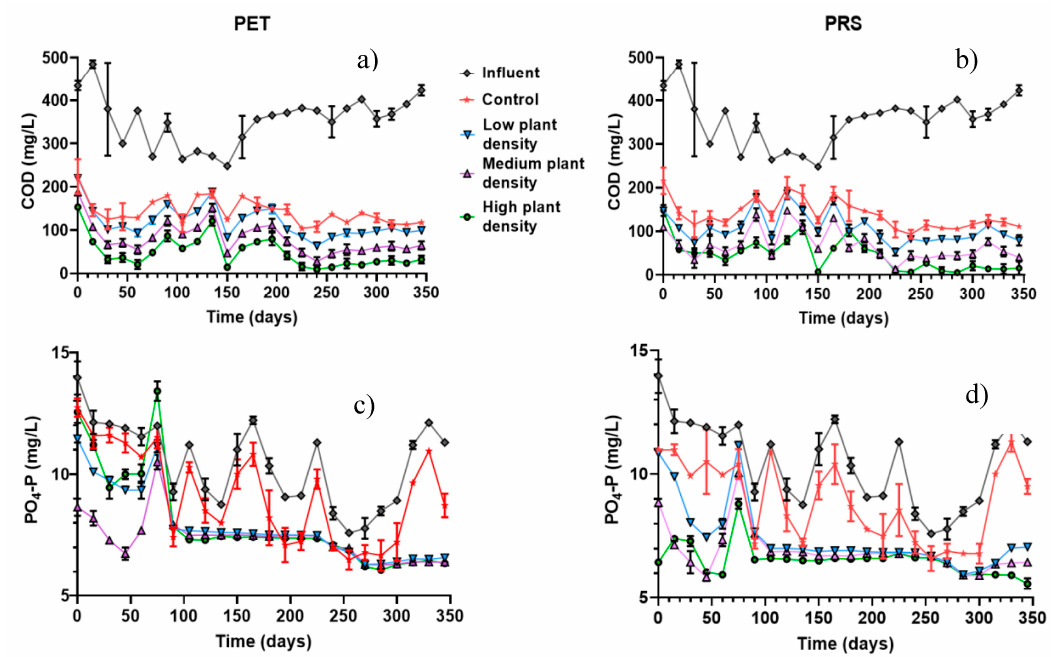
Figure 3. Contaminant concentration, ( a ) COD in PET, ( b ) COD in PRS, ( c ) PO 4 -P in PET and ( d ) PO 4 -P in PRS in effluents and influents in CWs with PET and PRS substrates.